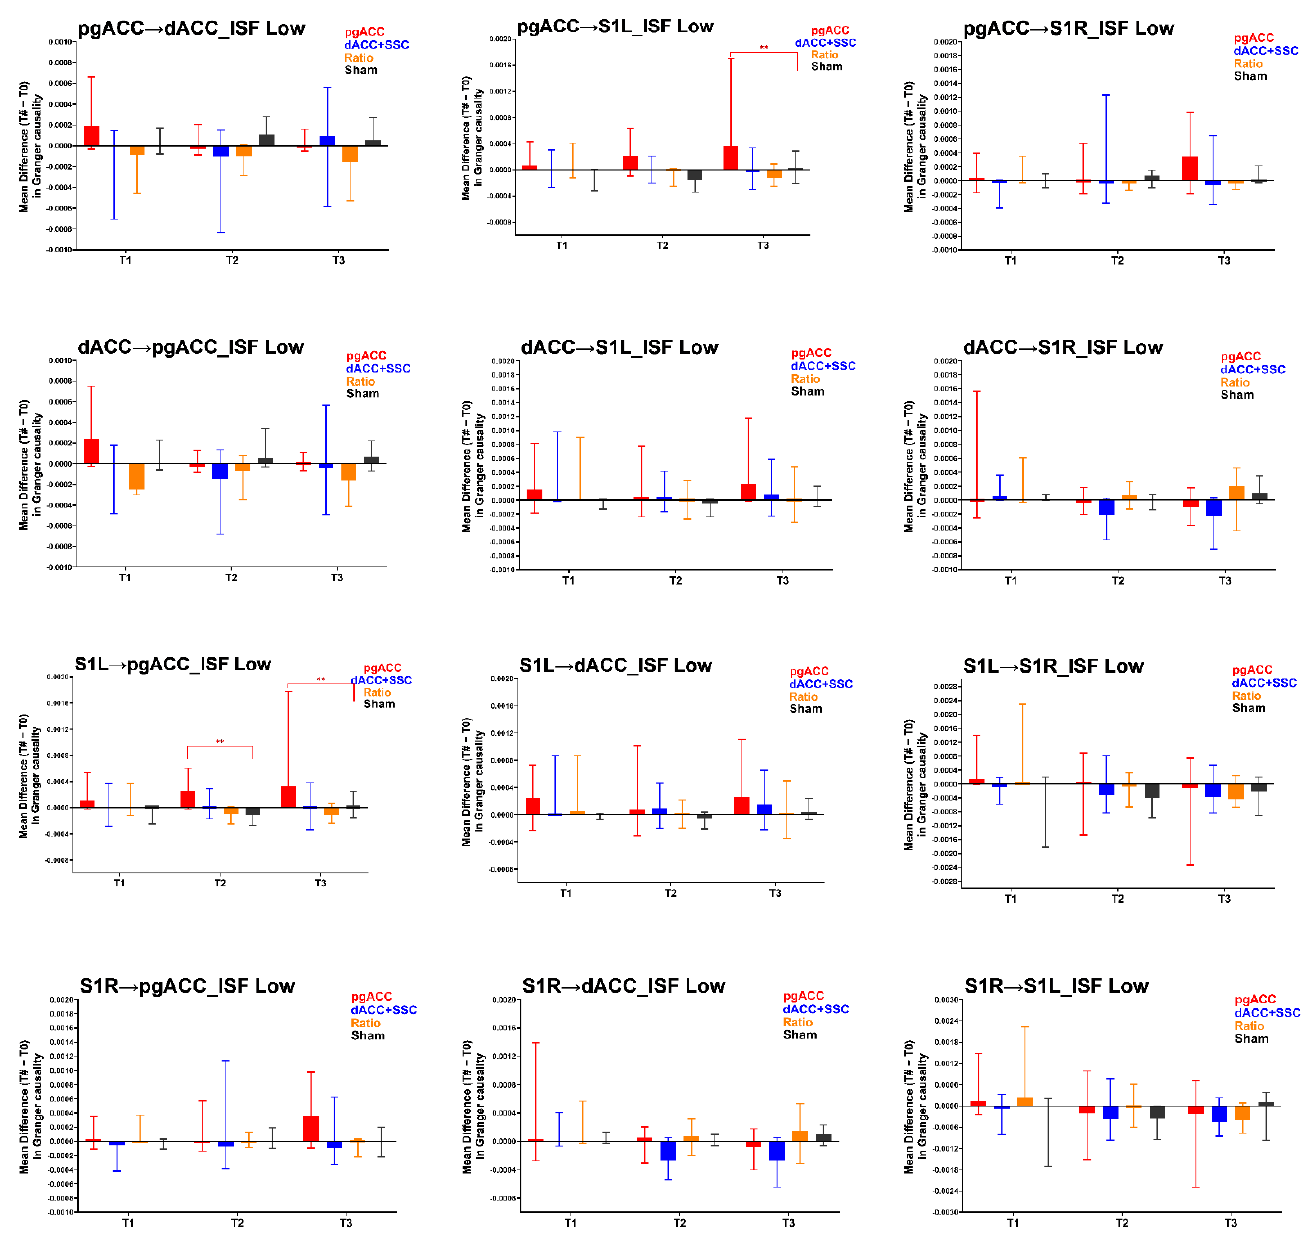
Figure 2. Results of the effective connectivity analysis for the ISF1 band (low:0.01 – 0.04Hz). pgACC: pregenual anterior cingulate cortex; dACC: dorsal anterior cingulate cortex; S1L: primary somatosensory cortex left; S1R: primary somatosensory cortex right; ISF: infraslow frequency; T1: changes immediately post-treatment when compared to baseline (T1 − T0); T2: changes at one-week follow up when compared to baseline (T2 − T0); T3: changes at one-month follow up when compared to baseline (T3 − T0); ->: effective connectivity in the direction of one region to other. Higher values represent increase in the effective connectivity compared to baseline. **: p < 0.017.